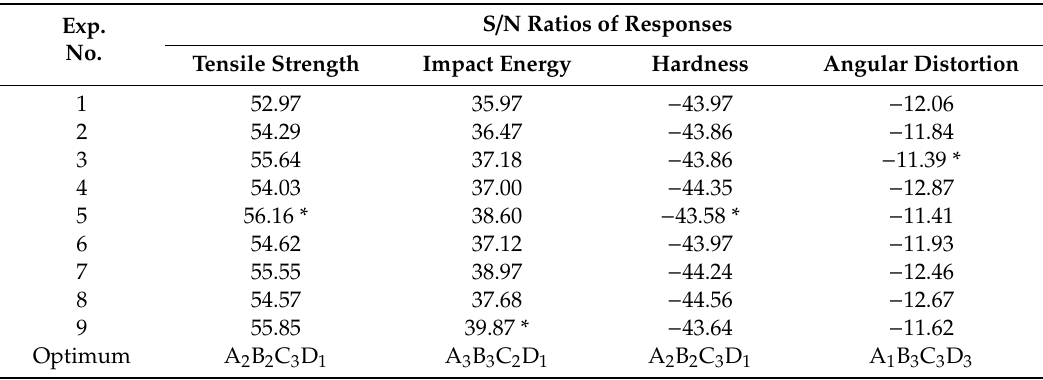
Table 6. Experimental design and results using L9